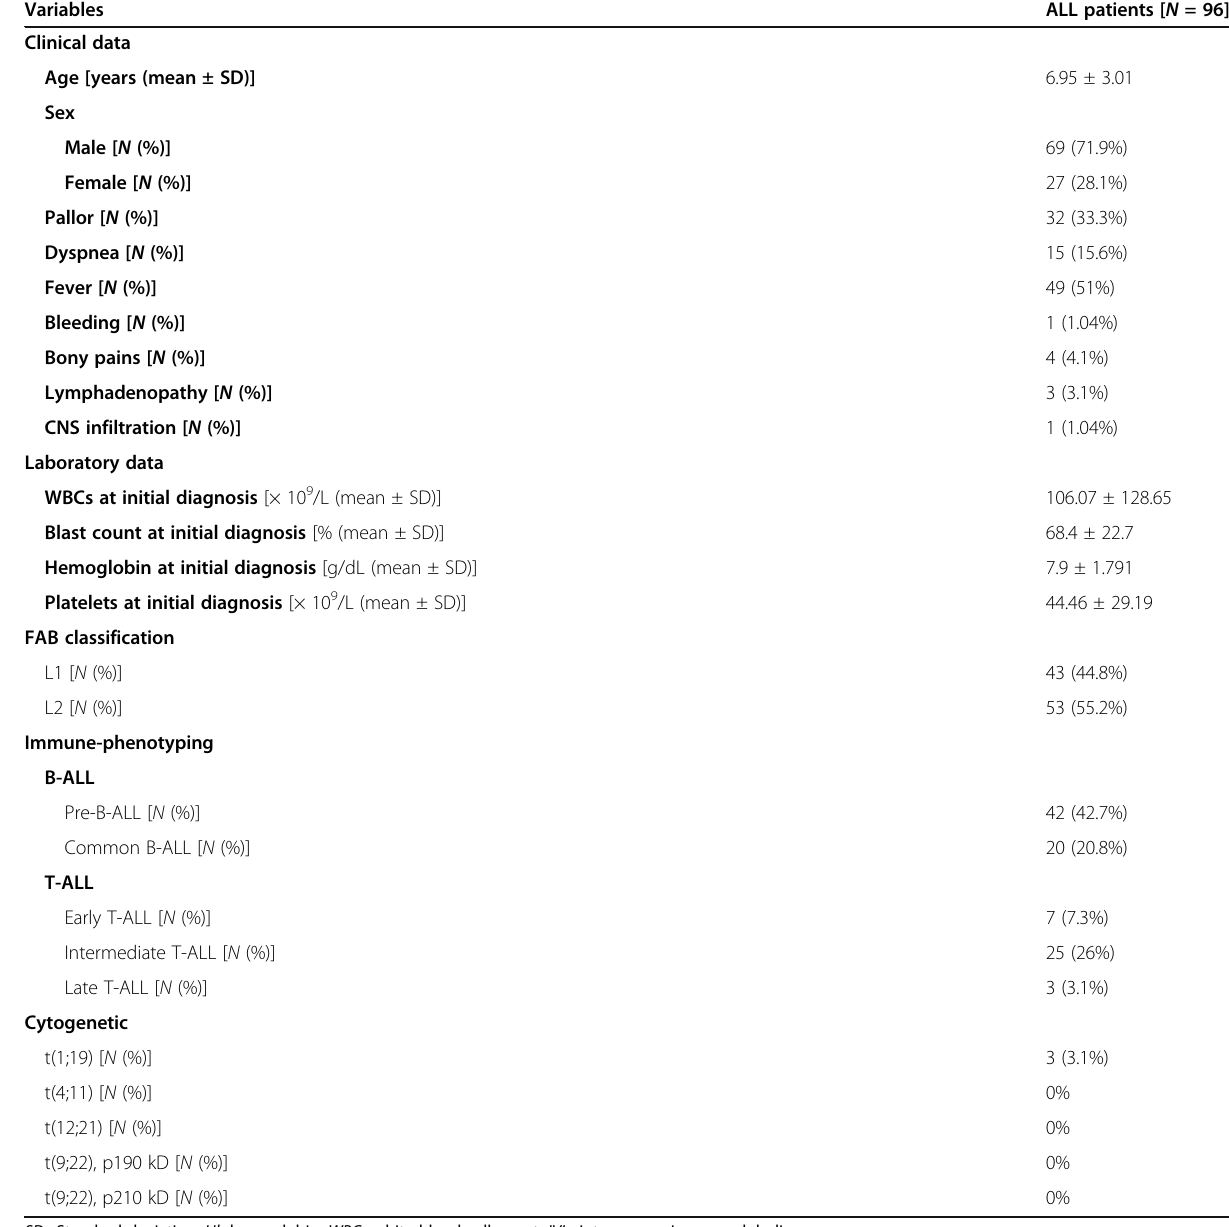
Table 1 Clinical and laboratory data of the ALL patients studied Variables ALL patients [ N = 96] Clinical